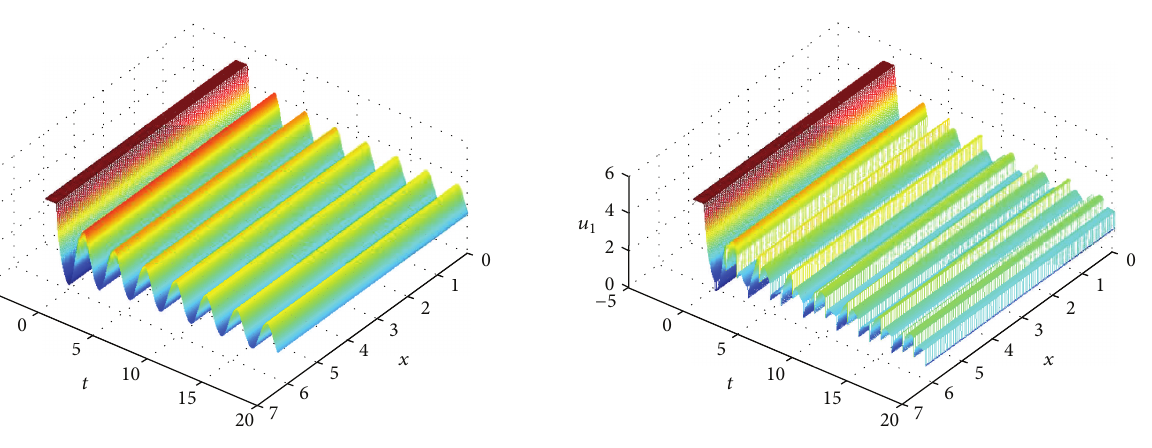
Figure 2: State response 𝑢1(𝑡,𝑥) of model (44) with impulsive